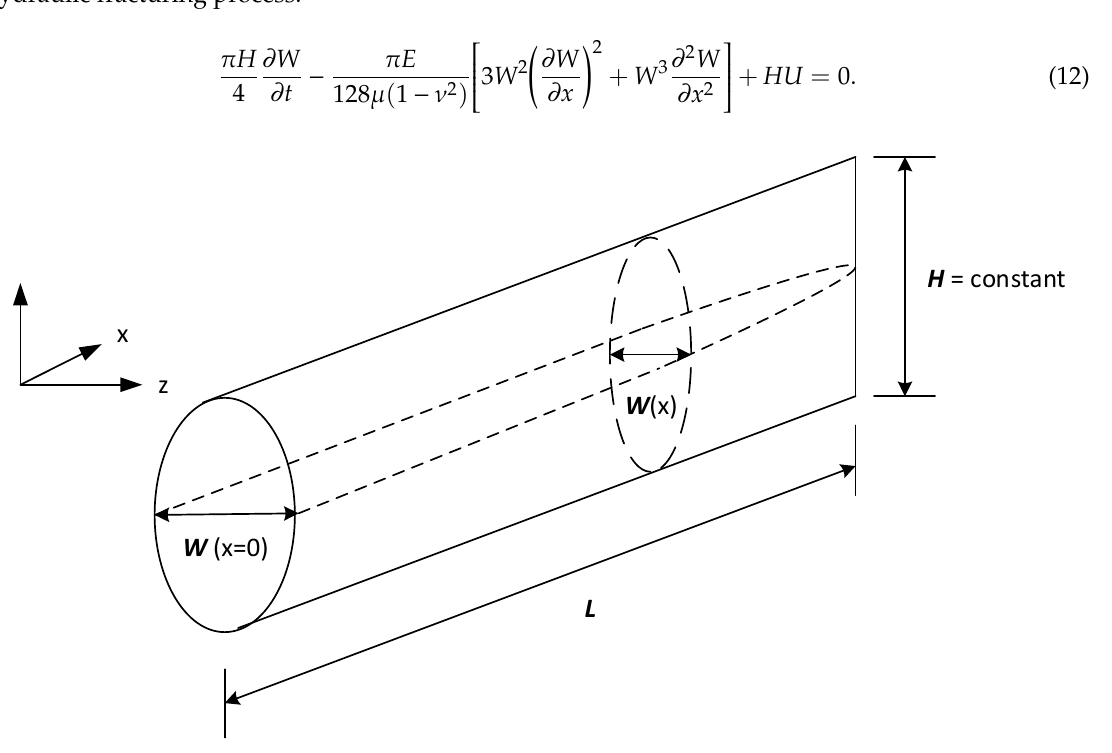
Figure 1. Perkins-Kern-Nordgren (PKN) hydraulic fracture model.